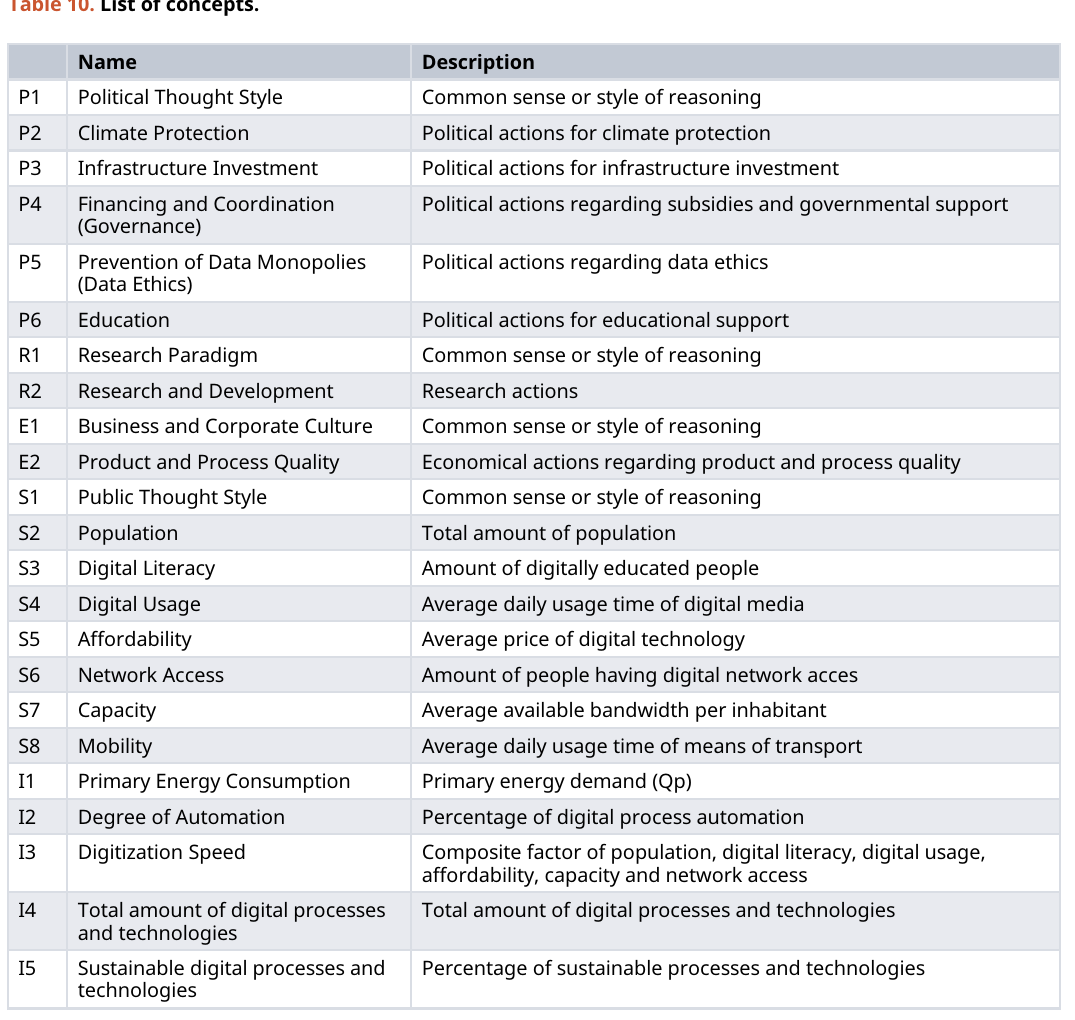
Table 10. List of